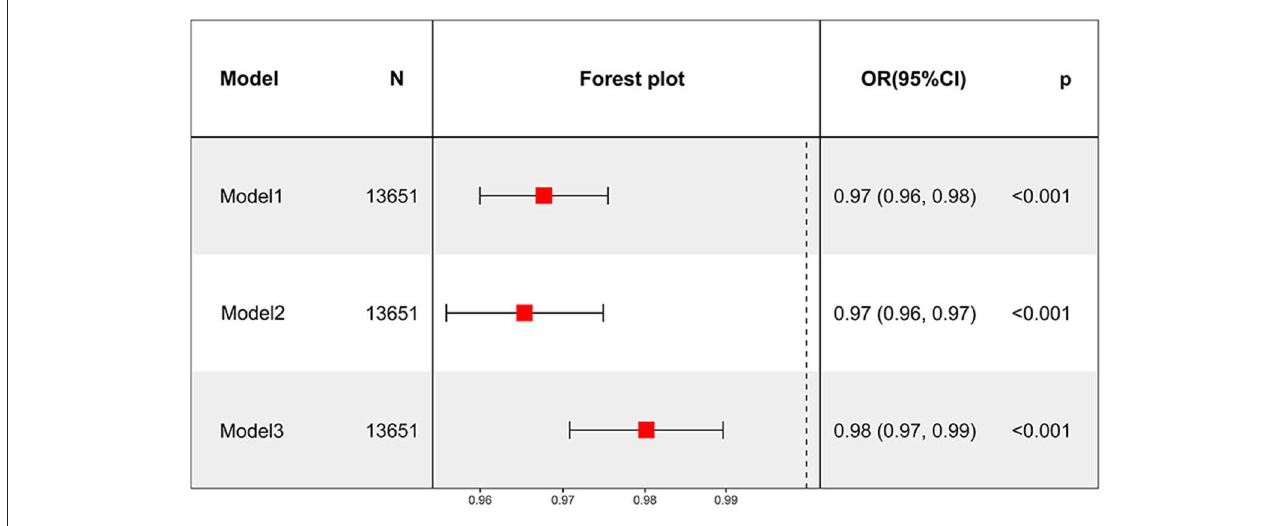
FIGURE3 Smoking cessation duration as a continuous variable to analyze the relationship between smoking cessation and depression.